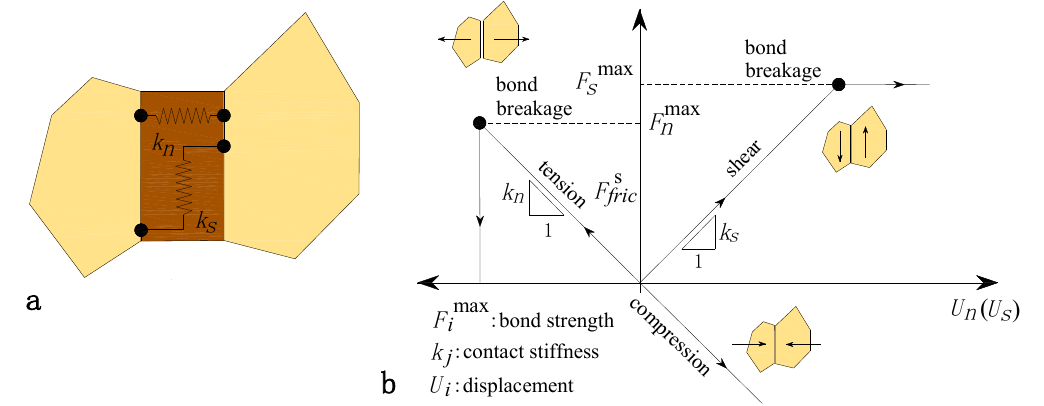
Figure 3. Joint constitutive model in UDEC. ( a ) Normal and shear stiffness between blocks. ( b ) Constitutive behavior in shear and tension (i = s, n) [7].